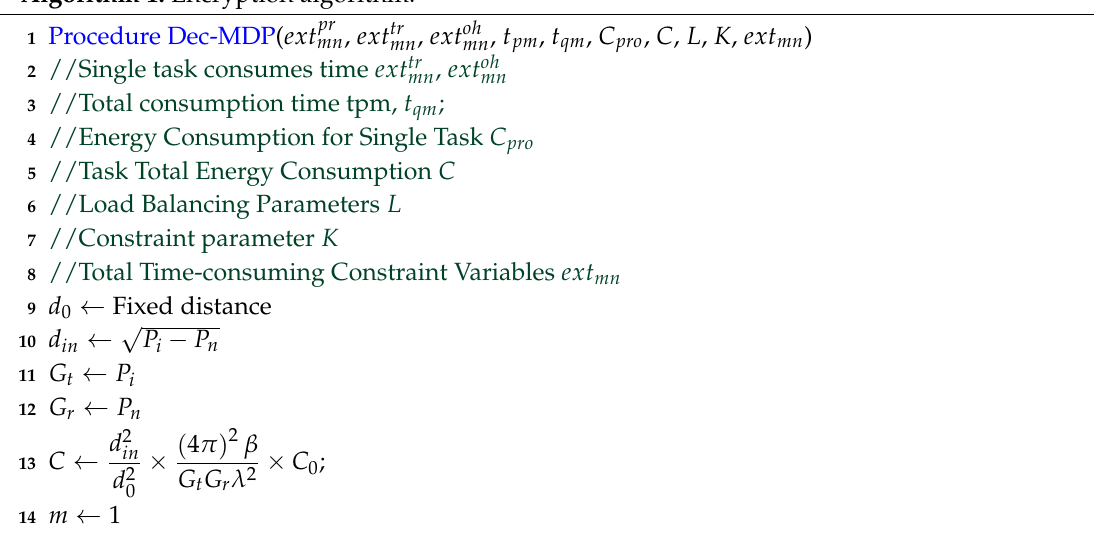
Algorithm 1: Encryption